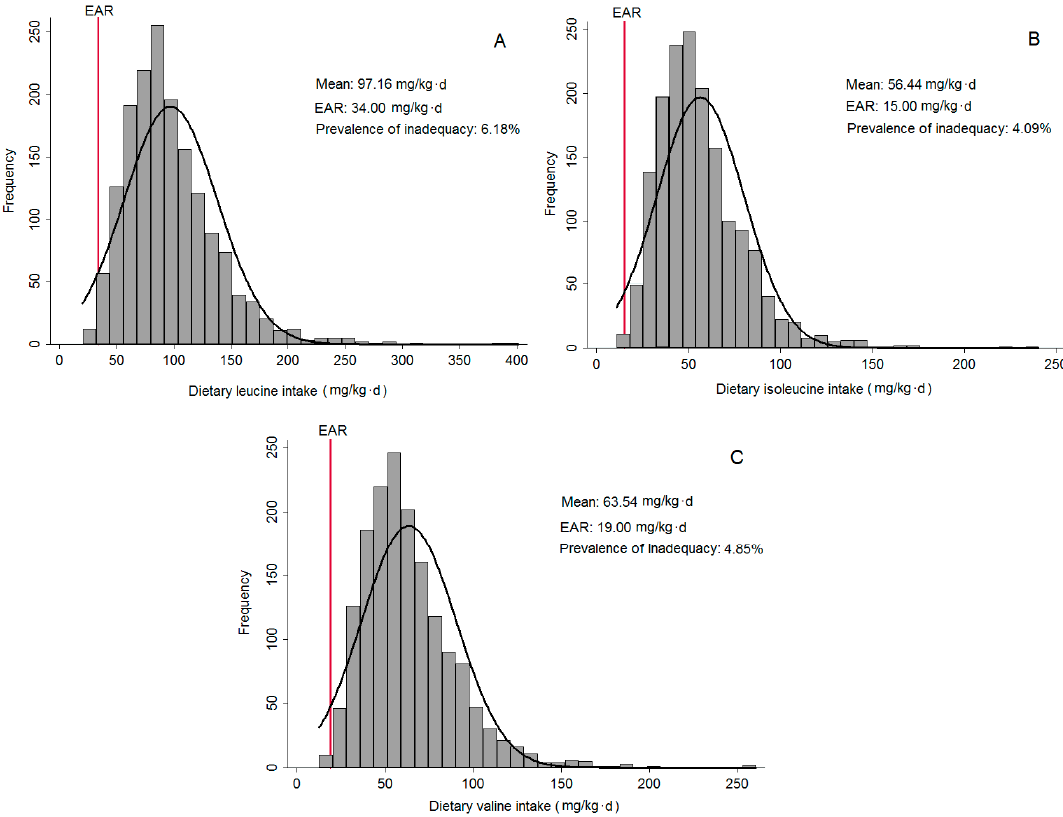
Figure 1. Distribution of dietary intake of leucine ( A ); isoleucine ( B ); and valine ( C ) of residents of the urban area of São Paulo. ISA-Capital, Sao Paulo, Brazil, 2008.